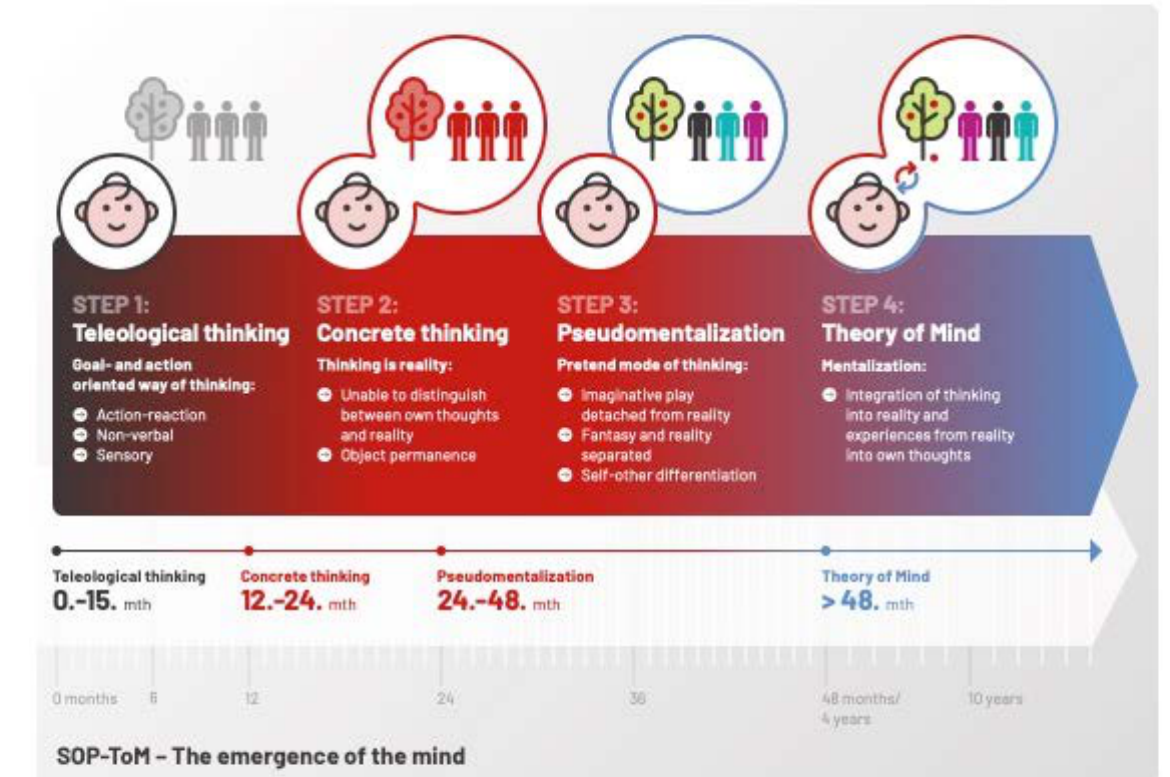
Figure 1. Milestones of development of the Theory of Mind network: Teleological thinking (0–15 months); concrete thinking (15–24 months); Pseudomentalization (24–48 months); Theory of Mind network (>48 months). Details c.f. [32,34].